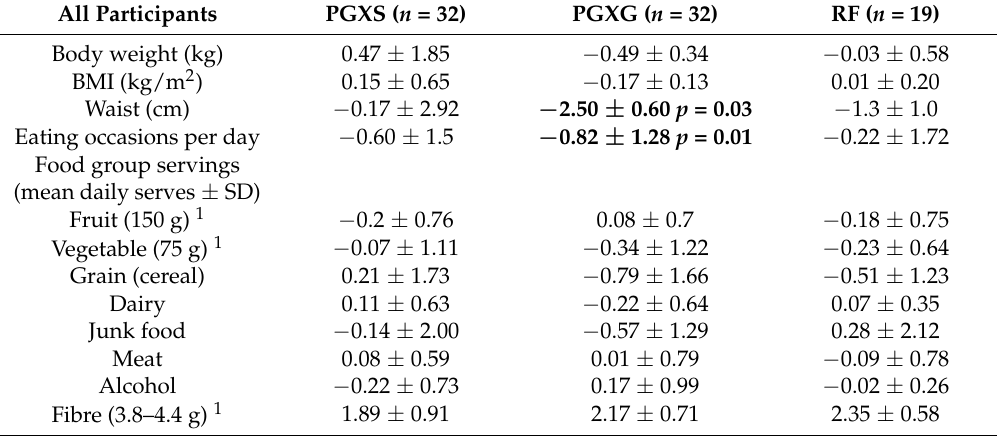
Table 4. Change in participant characteristics from baseline to week 12 of the interventions of all participants who completed the interventions (per-protocol